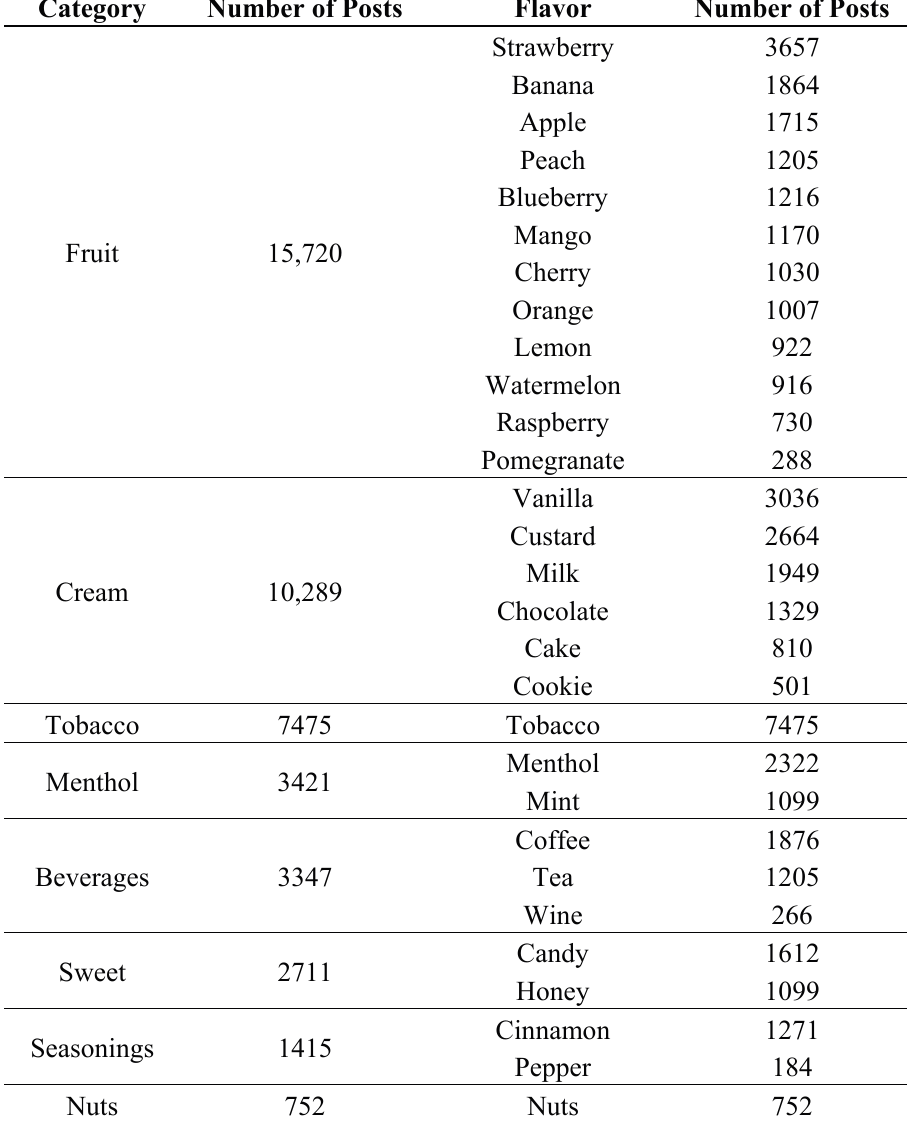
Table 2. Flavor category